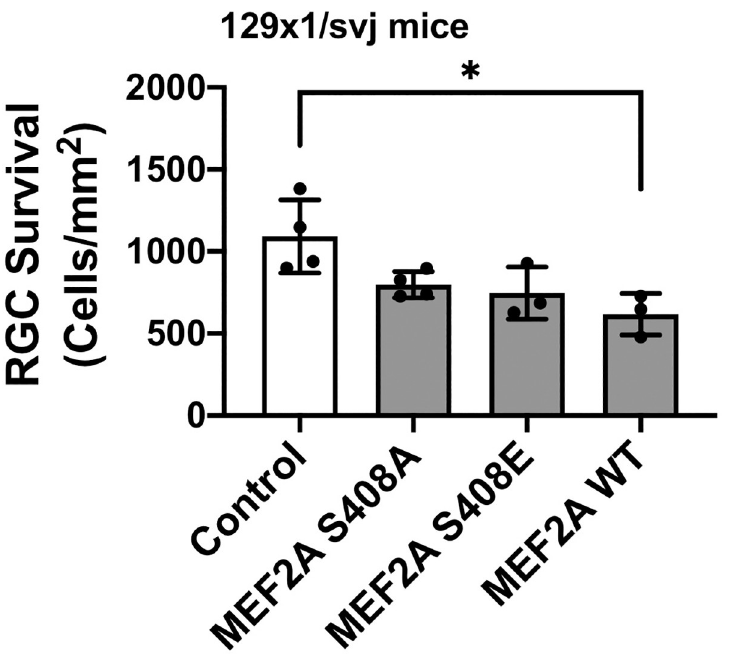
Fig 4. MEF2A over-expression promotes RGC loss after optic nerve crush. AAV2 expressing Flag-tagged MEF2A wildtype (WT), S408A, S408E mutants or luciferase control were injected into wild type mice two weeks before optic nerve crush. Two weeks post-crush, RPBMS-positive cells were counted following immunostaining of flat-mount retinas as in Fig 3. Data represent the absolute number of RGCs per unit area of the retina, and individual datapoints represent individual mice. Data were analyzed by one-way ANOVA and Tukey post-doc testing. Exogenous expression of wild-type Mef2a decreased RGC survival ( � p < 0.05); both S408A and S408E showed a similar trend towards decreasing RGC survival and were not statistically significantly different from Mef2a WT